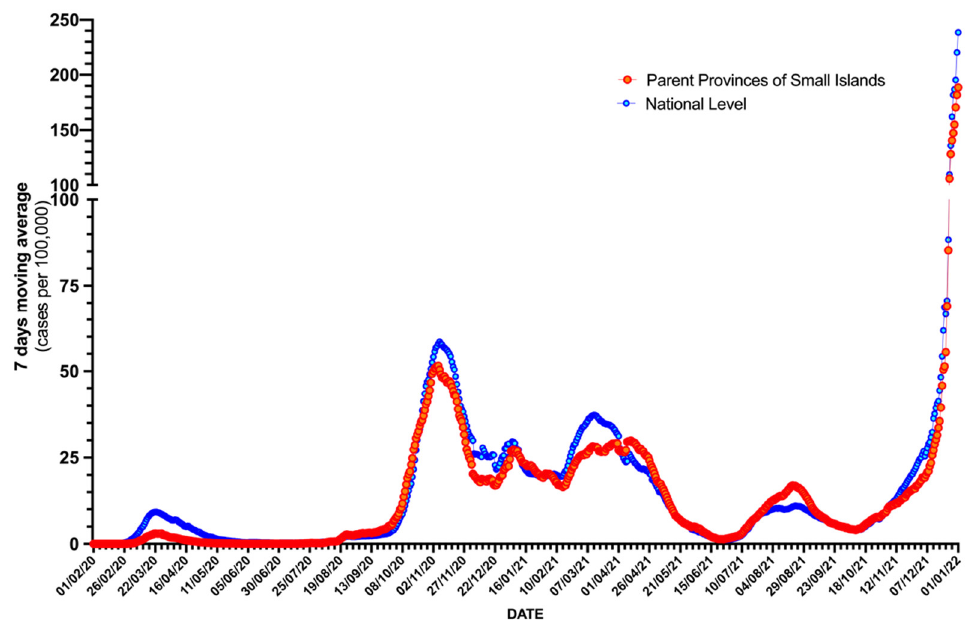
Figure 3. Notification rates (7-day moving average) for provinces including the communities of Ital- ian small islands, and national level estimates (1 February 2020; 31 December 2021).